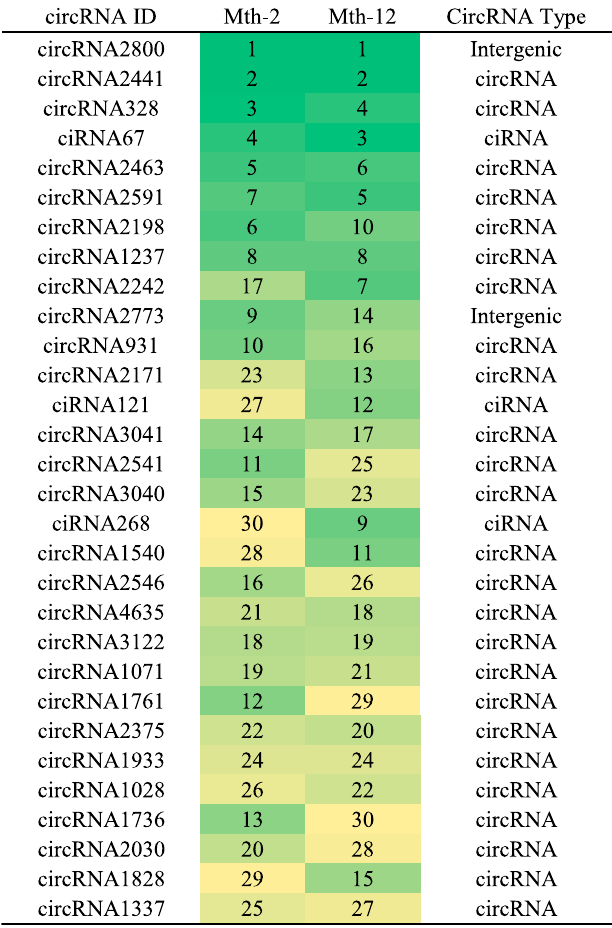
Green means higher expression and yellow means lower expression. The overrepresentation of green and yellow goes from high to low. The numbers from 1 to 30in each columnrepresentthe descendingorder